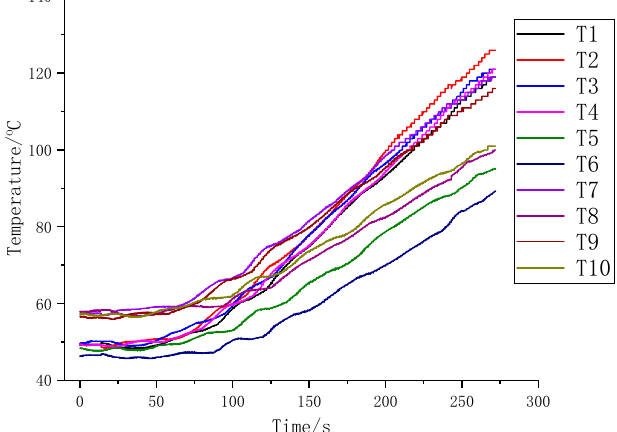
Figure 6. Typical temperature acquisition curve during module work.